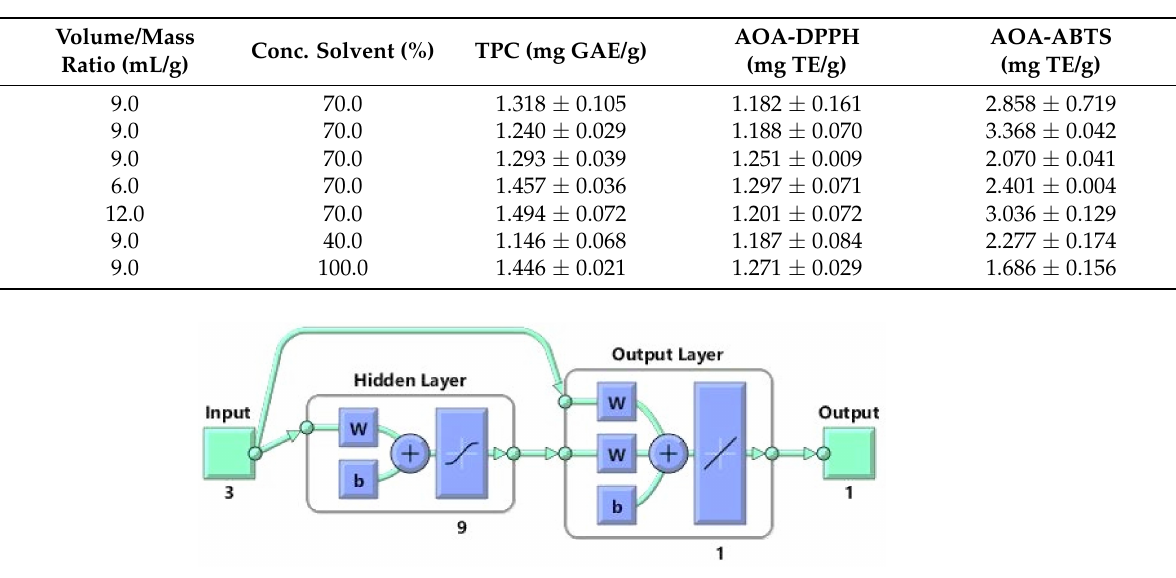
Table 3. Experimental results for TPC and AOA (DPPH and ABTS) considering different extracting conditions (values expressed as mean ± standard deviation).